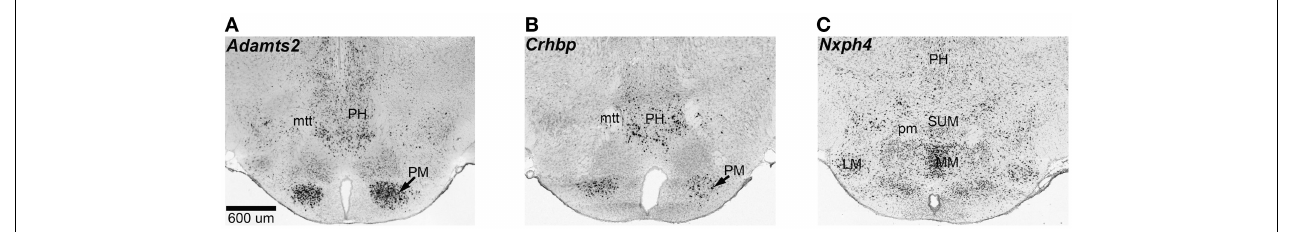
premammillary and posterior hypothalamic nuclei and Nxph4 has relatively intense expression in the lateral and medial mammillary areas. Several other members of F9/M9 show similar expression patterns. LM, lateral mammillary nucleus; MM, medial mammillary nucleus; mtt, mammillothalamic tract; PH, posterior hypothalamus; pm, principal mammillary tract; PM, premammillary nucleus; SUM, superior